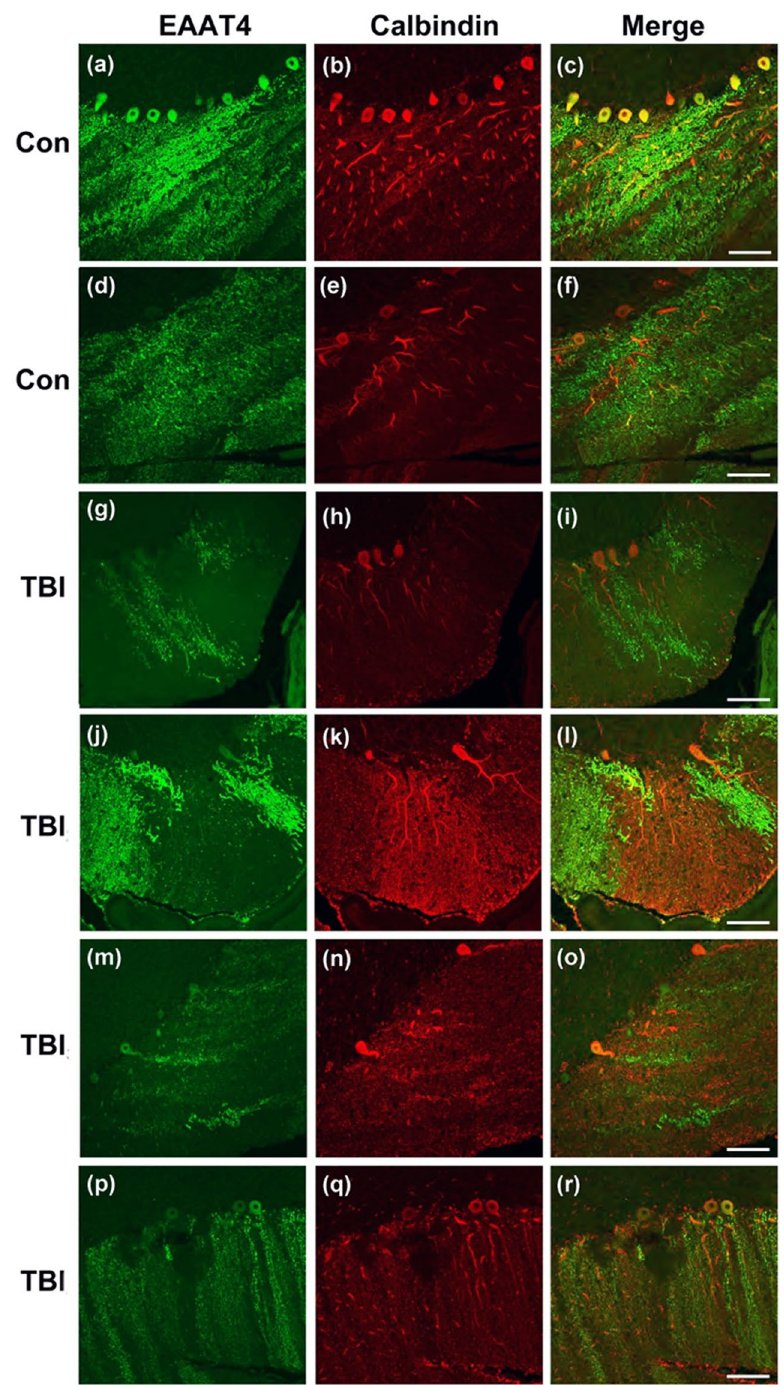
Figure 8. Dystrophic EAAT4 expression in cerebellar Purkinje cells in human with blast-related mTBI. Confocal microscopy shows representative immunofluorescent images of EAAT4 (green), and calbindin (red) in the cerebella of Veteran/military Servicemember controls with no blast TBI ( a – c and d – f , Controls 1 – 2 , respectively described in Results), and in the cerebellum of Veteran/military Servicemembers with